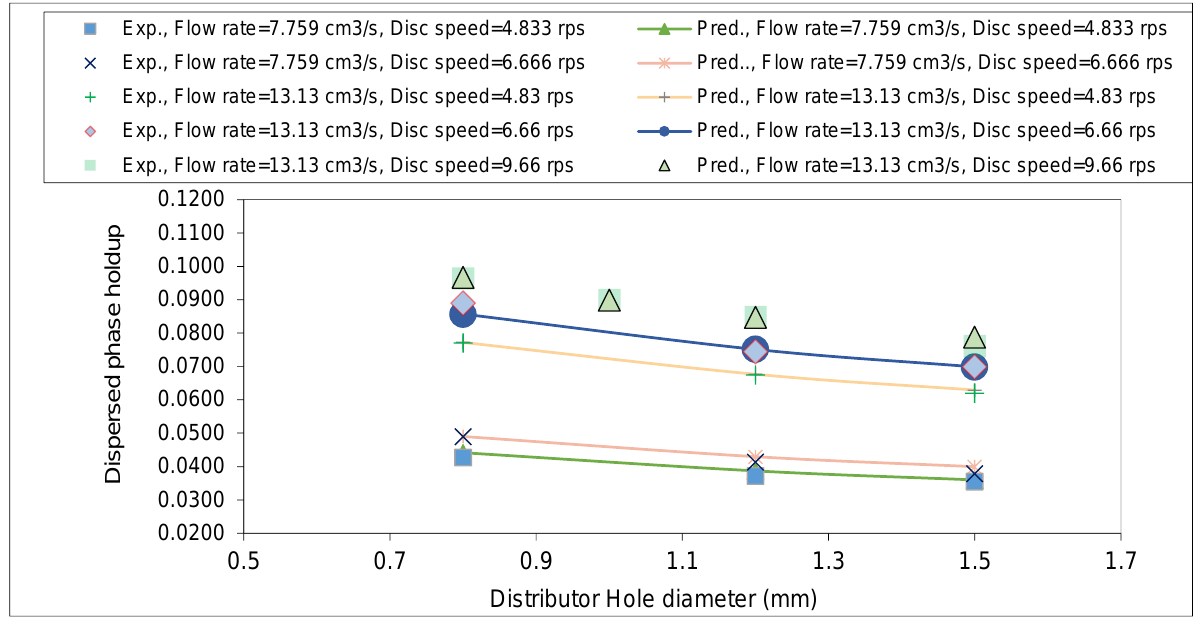
Figure 2. Measured and predicted holdup influence of distributor hole diameter. Measured holdup (symbols) and predicted holdup (lines).